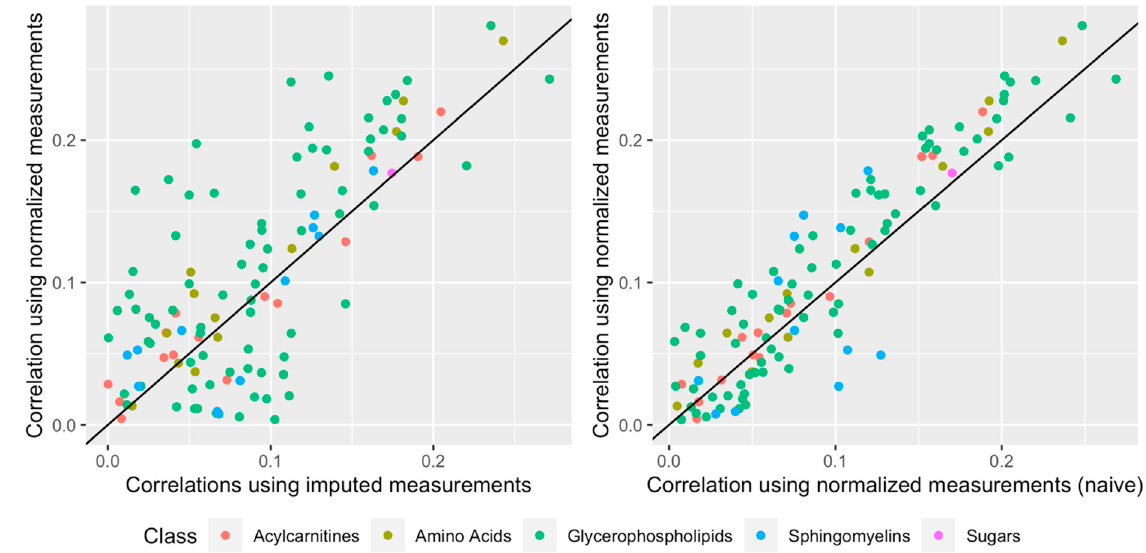
Figure 6. Correlations (absolute values) between BMI and the 117 metabolites in control samples. The y − axis represents values computed with normalized measurements produced by our approach, while the x − axis represents values computed with imputed (non-normalized) measurements ( left ), and normalized measurements produced by the simpler normalization approach ( right ), which corrected for study and batch effects without specifically attempting to preserve variation due to study center, BMI, gender, and alcohol intake.